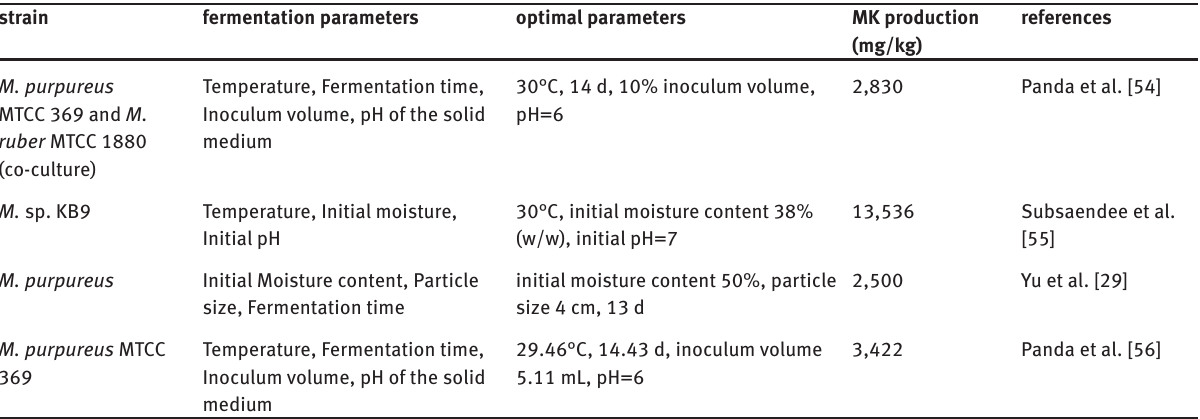
Table 4: Comparison of MK Yield by Monascus Fermentation Under Different parameters.